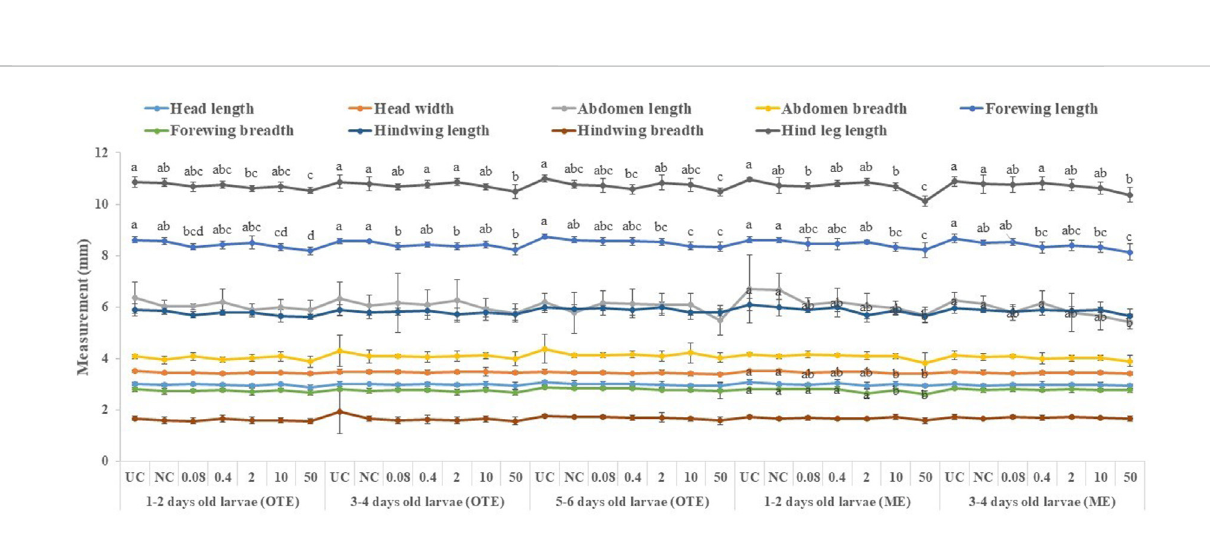
FIGURE 6 Morphological variations in adult honey bees developed from larvae after OTE and ME to captan. UC, untreated control; NC, negative control; OTE, one-timeexposure;ME,multipleexposures.Thedifferentsmallletters(a,b ... )withinacolumnindicatesigni fi cantdifferencesbyTukey ’ sHSD( p <